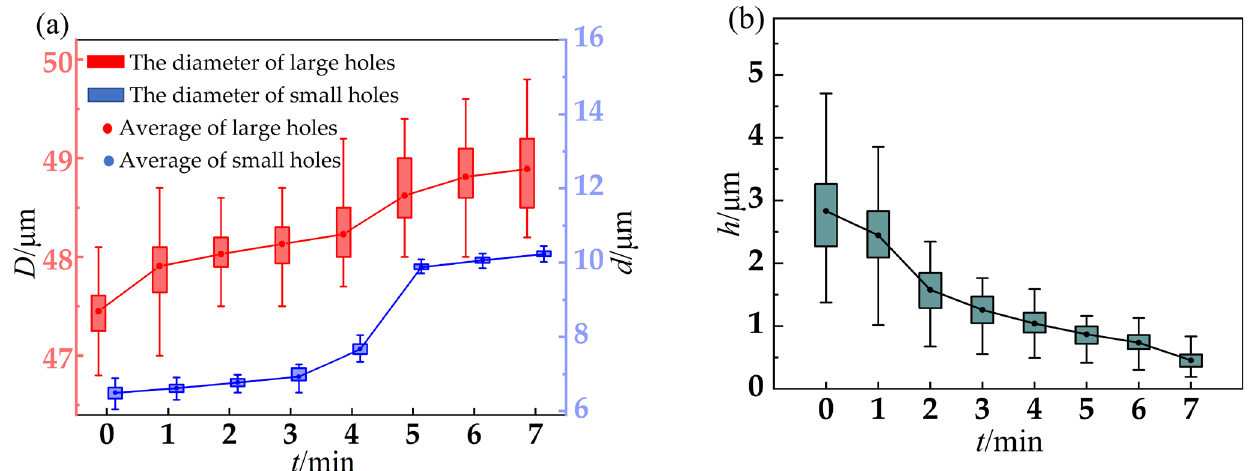
Figure 5. The relationship between electrolytic polishing time and metal sheet: ( a ) Relationship between electrolytic polishing time and the diameter of micro-tapered holes; ( b ) Relationship between electrolytic polishing time and burr height.